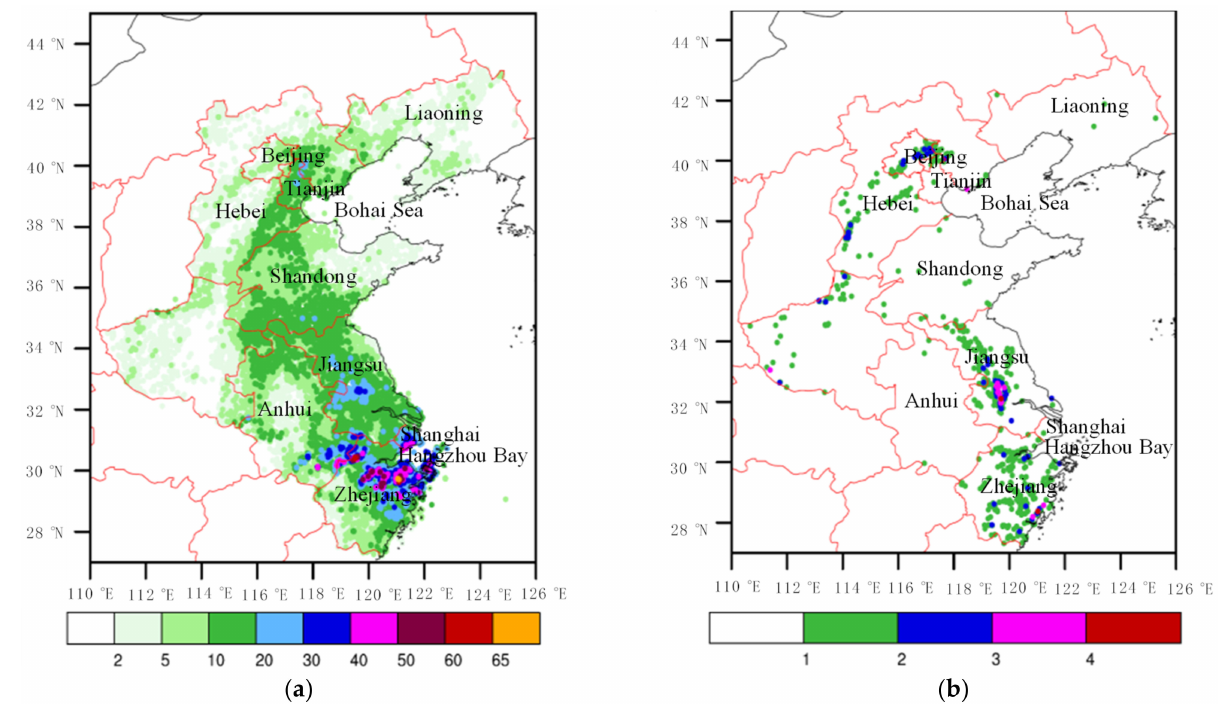
Figure 5. Precipitation duration time of In-Fa (unit: h). ( a ) hourly rainfall ≥ 5 mm h − 1 , and ( b ) hourly rainfall ≥ 40 mm h − 1